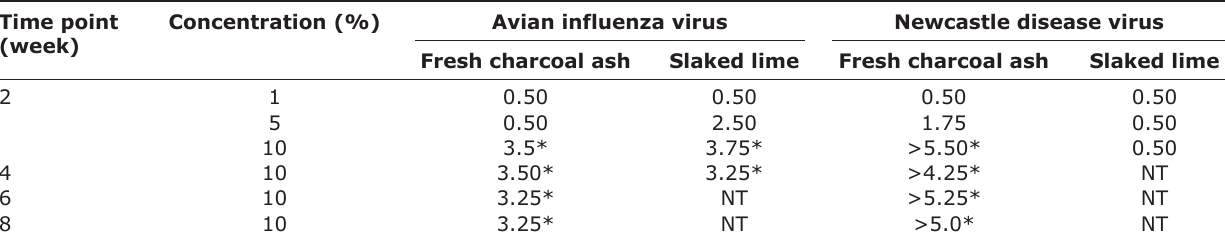
Table-5: The RF (log TCID /ml) of fresh charcoal ash and slaked lime solution applied for inactivating Newcastle 10 50 disease virus and Avian influenza virus after being kept at room temperature with a 3-min incubation period. Time point